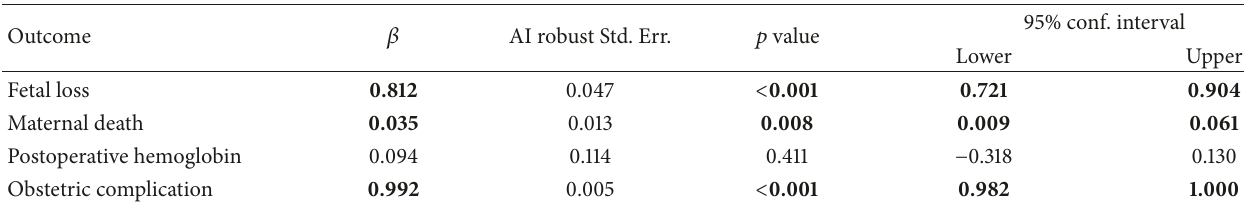
Table 5: Bad outcomes of uterine rupture among females in the catchment area by extrapolation, MTU, 2016. Outcome 𝛽 AI robust Std.